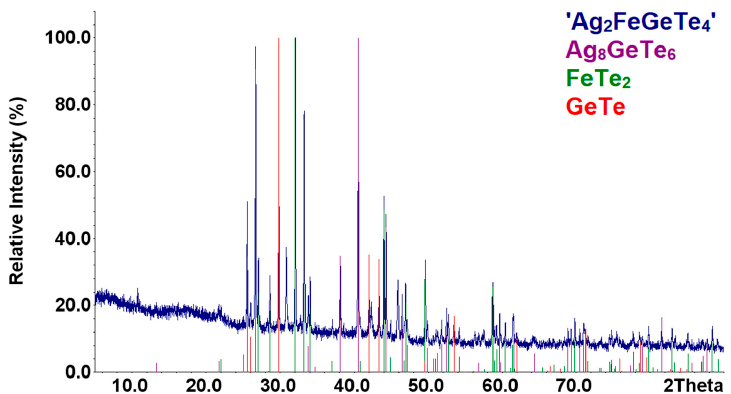
Figure 4. XRD patterns of the sample ‘Ag 2 FeGeTe 4 ’ as compared with those theoretical patterns of the